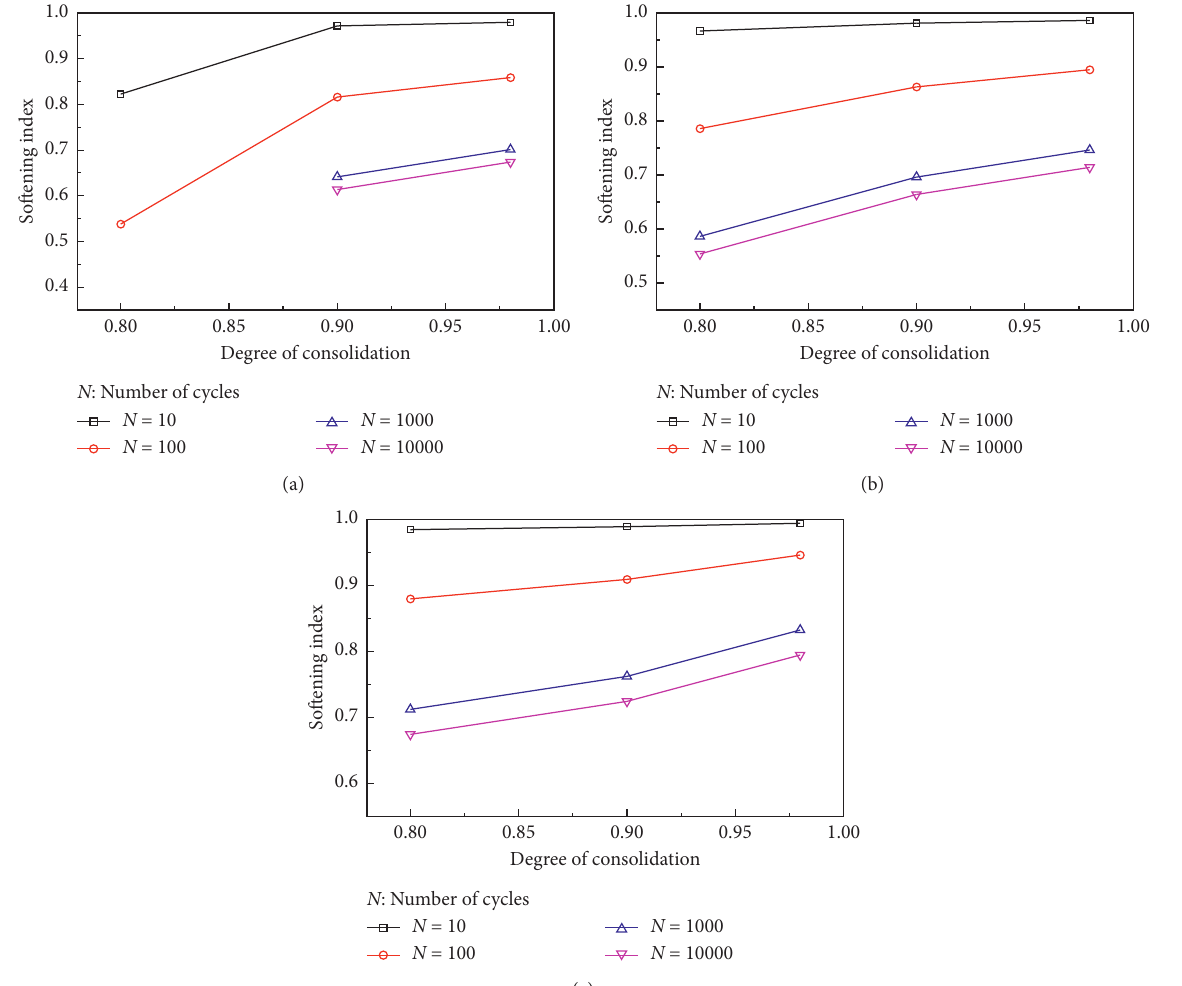
Figure 8: Curve of degree of consolidation and softening index under different number of cycles: (a) P � 20% and σ P � 20% and σ ′ � 200kPa; (c) P � 20% and σ 3